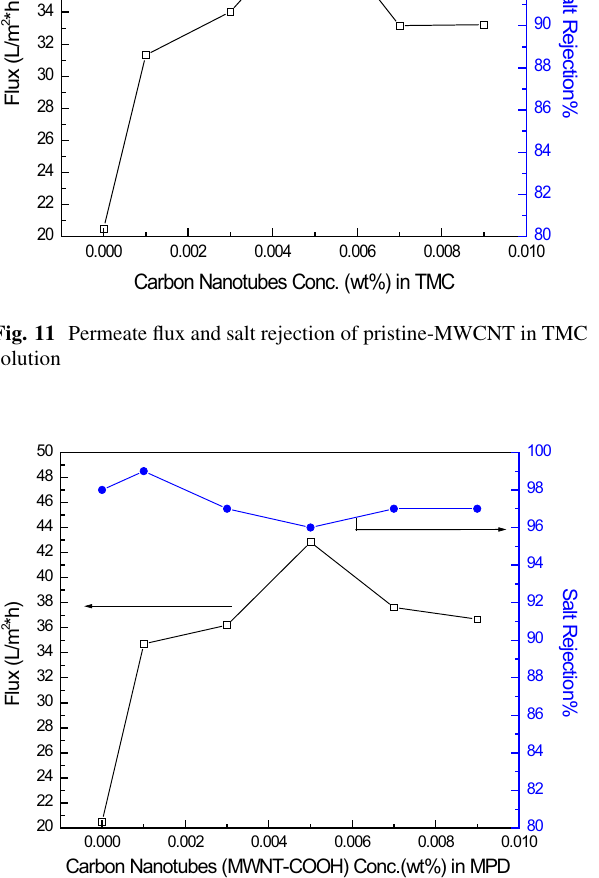
Fig. 12 Permeate flux and salt rejection of MWCNT–COOH in MPD